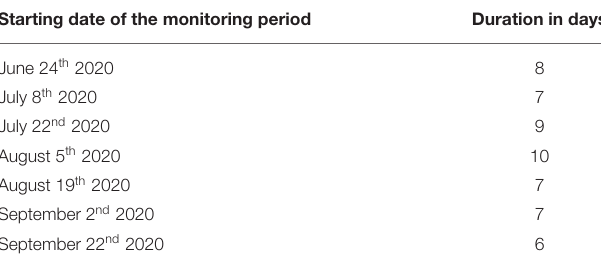
TABLE 1 | Description of the monitoring